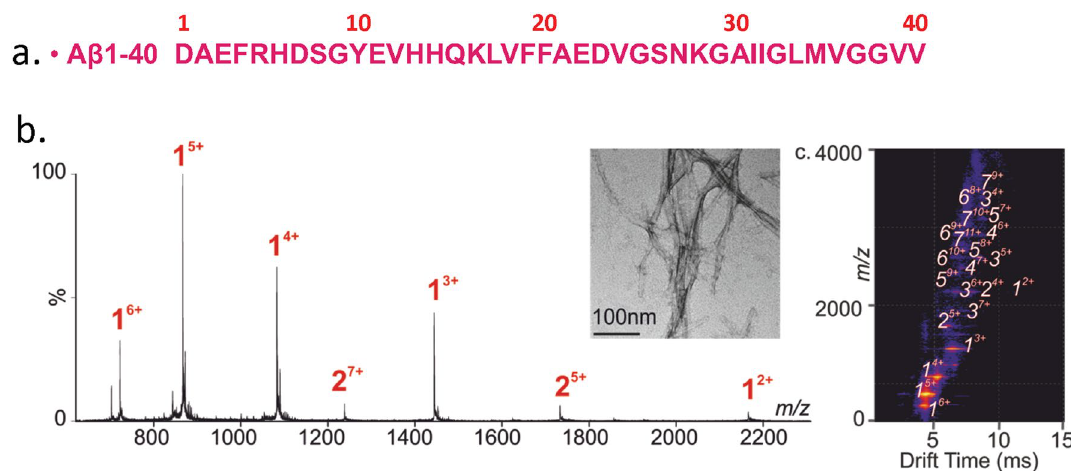
Figure 2. Aβ 1-40 forms an array of oligomeric species during fibril formation. ( a ) Primary sequence of the Aβ 1-40 peptide. ( b ) The ESI mass spectrum of the Aβ 1-40 peptide acquired on a Synapt HDMS mass spectrometer. The oligomer order is denoted above the mass spectral peak along with the positive-charge state of the ion as superscript. ( c ) The ESI IM-MS Driftscope plot of the Aβ 1-40 monomer (1) through the heptamer (7). The TEM image of the Aβ 1-40 sample after 48 h of incubation (water pH 5.8, quiescent, 25 °C) is shown in the inset (scale bar 100